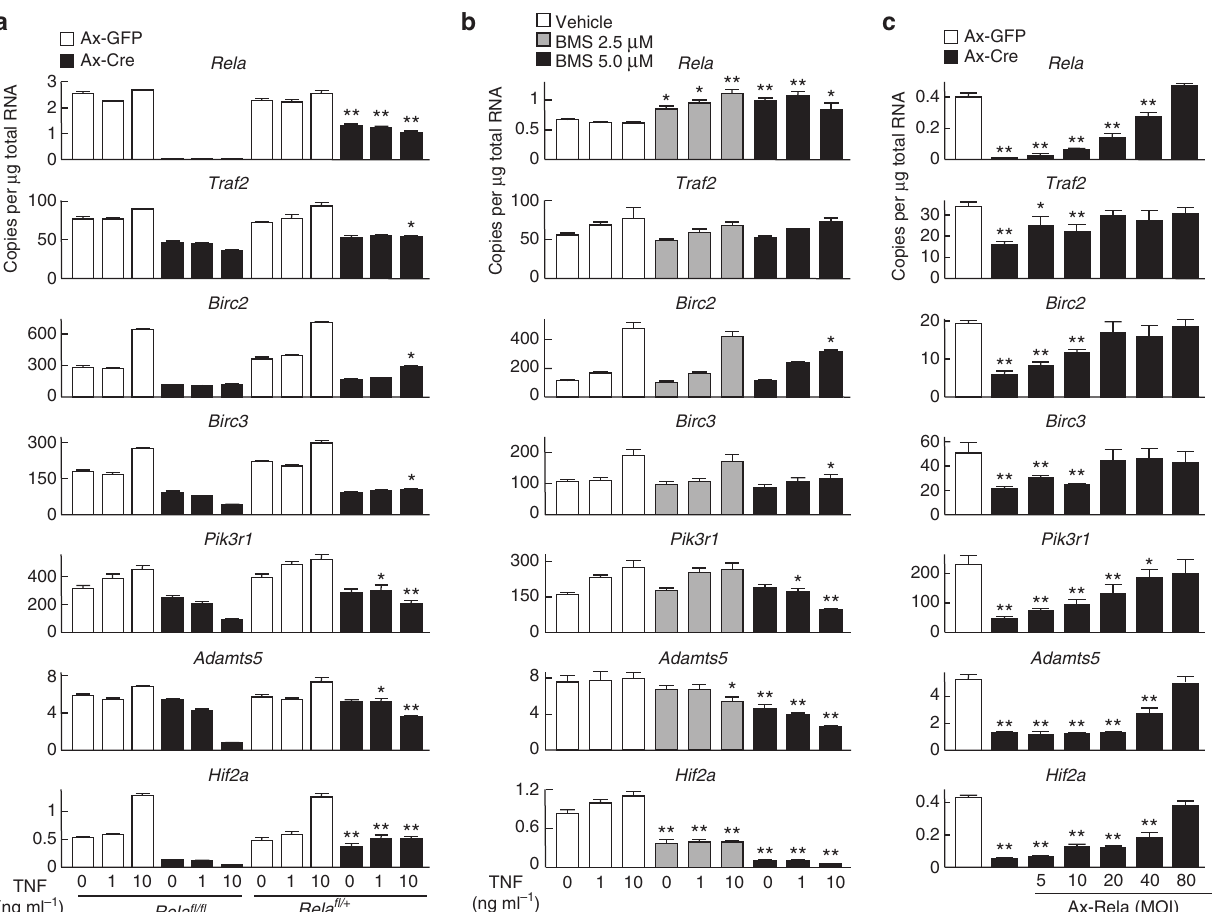
0 1 10TNF (ng ml –1 ) Figure 8 | Transcription of the target genes under various conditions of Rela or NF- j B signalling. ( a ) mRNA levels of the target genes in Rela fl/fl and Rela fl/ þ primary chondrocytes overexpressing GFP (Ax-GFP) or Cre (Ax-Cre) by adenoviral induction with or without TNF treatment. Adenovirus infection was performed at a multiplicity of infection (MOI) of 50. Data are expressed as the means ± s.d. of three wells per group. * P o 0.05, ** P o 0.01 versus Cre- overexpressing Rela fl/fl chondrocytes treated with the same dose of TNF; Student’s t -test. ( b ) mRNA levels of the target genes in Rela fl/fl primary chondrocytes treated with DMSO (vehicle) or 2.5 and 5 m M BMS-345541 (IKK inhibitor) with or without TNF stimulation. Data are expressed as the means ± s.d. of three wells per group. * P o 0.05, ** P o 0.01 versus the vehicle control treated with the same dose of TNF; Student’s t -test. ( c ) mRNA levels of the target genes in Rela fl/fl primary chondrocytes transduced with Cre and Rela by adenoviral vectors. GFP or Cre was transduced at an multiplicity of infection (MOI) of 20. The amount of Rela adenovirus varied from an MOI of 5–80. Data are expressed as the means ± s.d. of three wells per